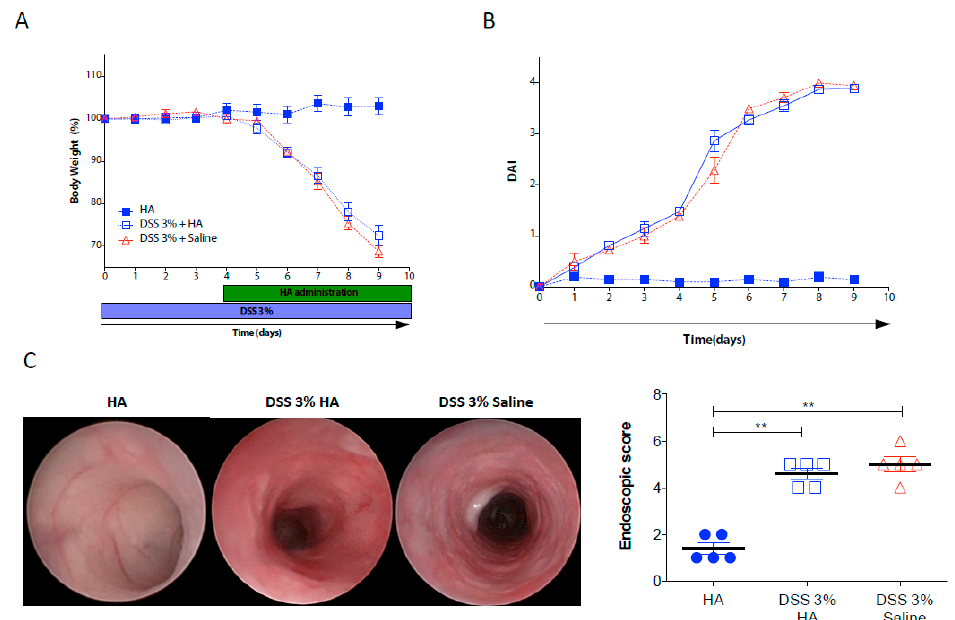
Figure 1. Hyaluronan (HA) treatment did not ameliorate the acute phase of experimental colitis. ( A , B ) Body weight and disease activity index (DAI) monitored over 9 days of dextran sulfate sodium (DSS)-induced colitis in C57BL/6N wild type mice receiving applications of high molecular weight HA (1mg/mL) or saline every other day via enema, commencing from day 4. Healthy mice receiving only HA served as controls. C Representative endoscopic images of the intestinal mucosa and endoscopic score (summarising the mucosal damage) at day 9 of DSS administration. Data represent the mean values ± SEM ( n = 5/group); ** p < 0.01 compared to control group by one-way-ANOVA.